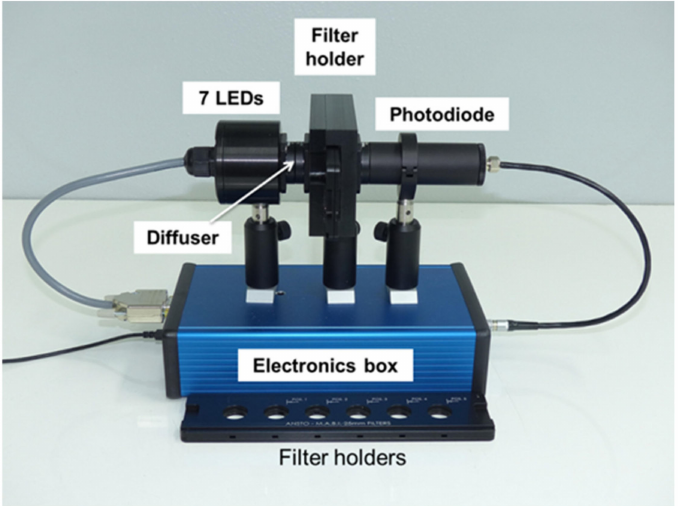
Figure 2. ANSTO Multi-wavelength absorption black carbon instrument (MABI)